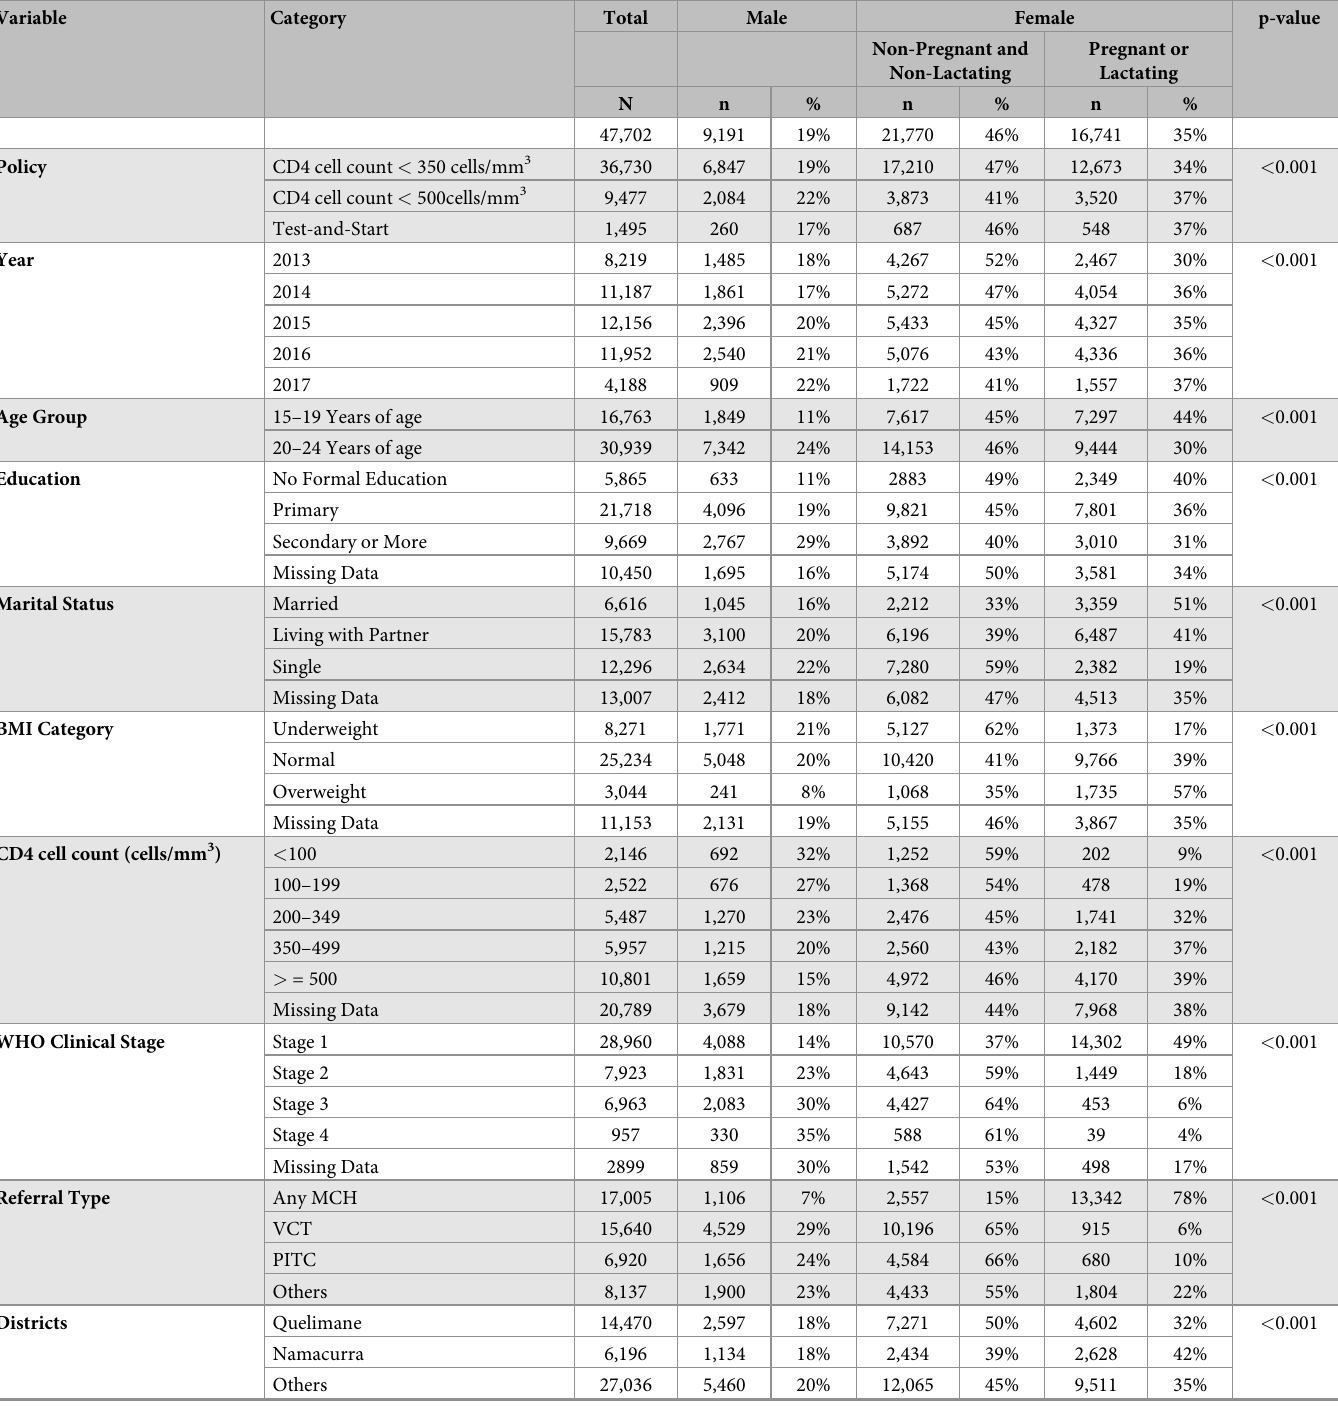
Table 1. Baseline cohort